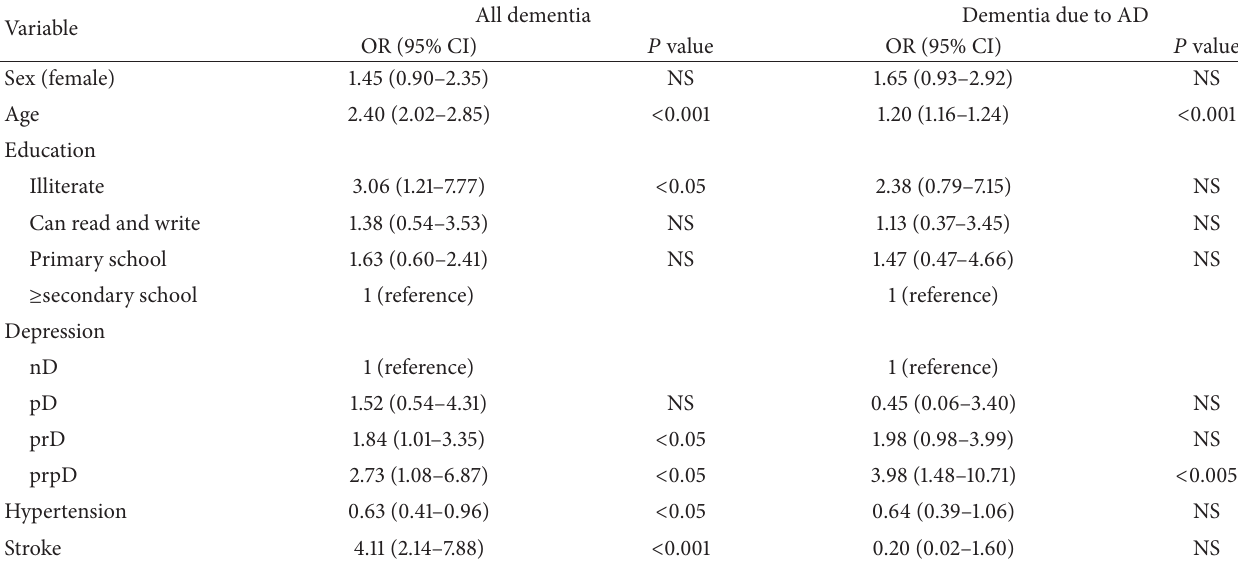
Table 3: Final regression model for dementia prevalence at